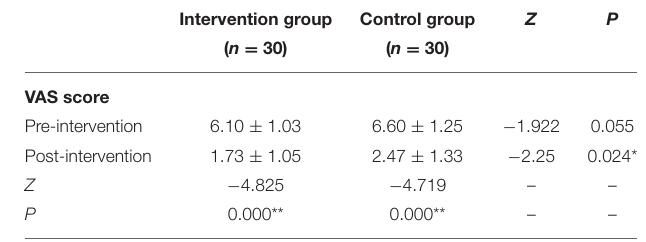
TABLE 4 | Non-invasive cardiac output at the end of 6MWT (x ± s). TABLE 5 | VAS score between groups (x ± s).